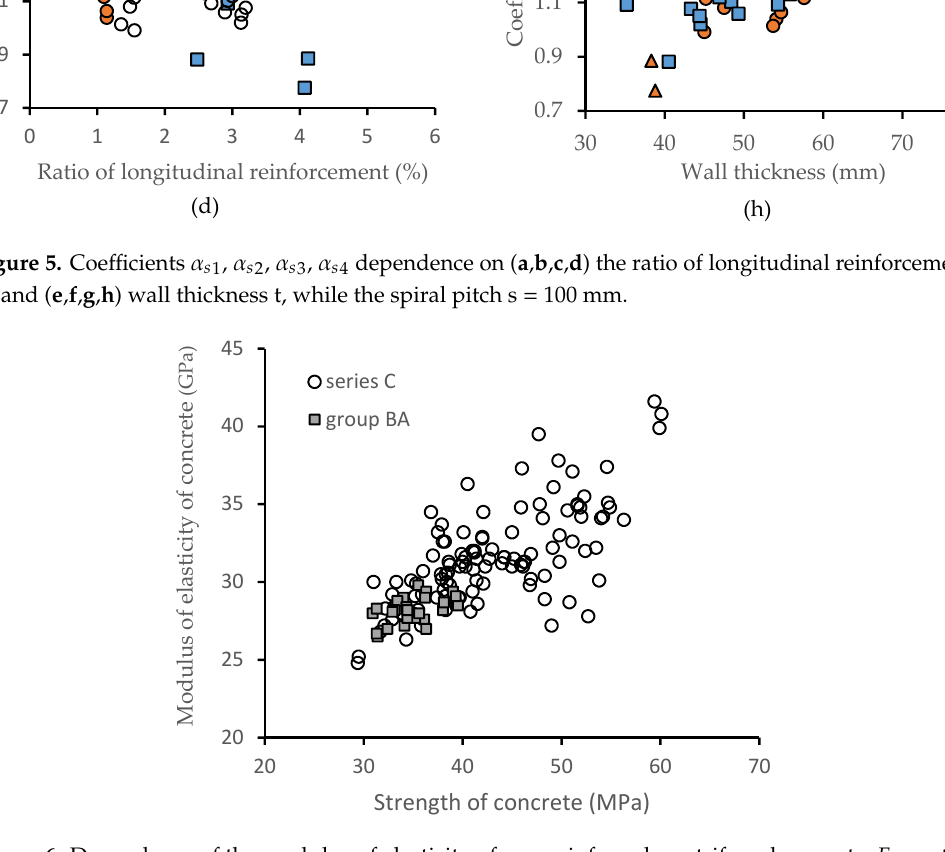
Figure 6. Dependence of the modulus of elasticity of non-reinforced, centrifuged concrete, E c , on the concrete strength, f c .